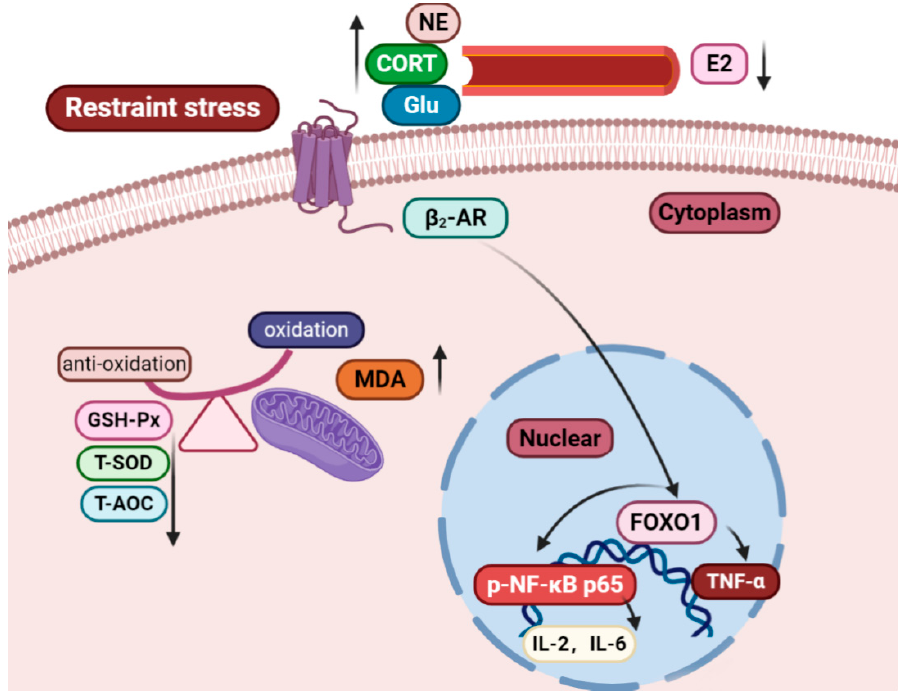
Figure 9. The antioxidative levels and relative protein levels and the mediating role of FOXO1 in p-NF- κ B p65 and β 2 -AR. Restraint stress caused disorder in the endocrine system, leading to a significant increase in levels of the oxidative stress-related factors FOXO and β 2 -AR and suggesting a cascade of oxidative stress in pregnant mothers under oxidative stress. β 2 -AR affected the activity of FOXO1 while inhibiting the activity of p-NF- κ B p65 and then inhibited the target gene of p-NF- κ B p65. FOXO1 may play an important mediating role between β 2 -AR and NF- κ B p65. The upward arrow represents an increase, while the downward arrow represents a decrease.